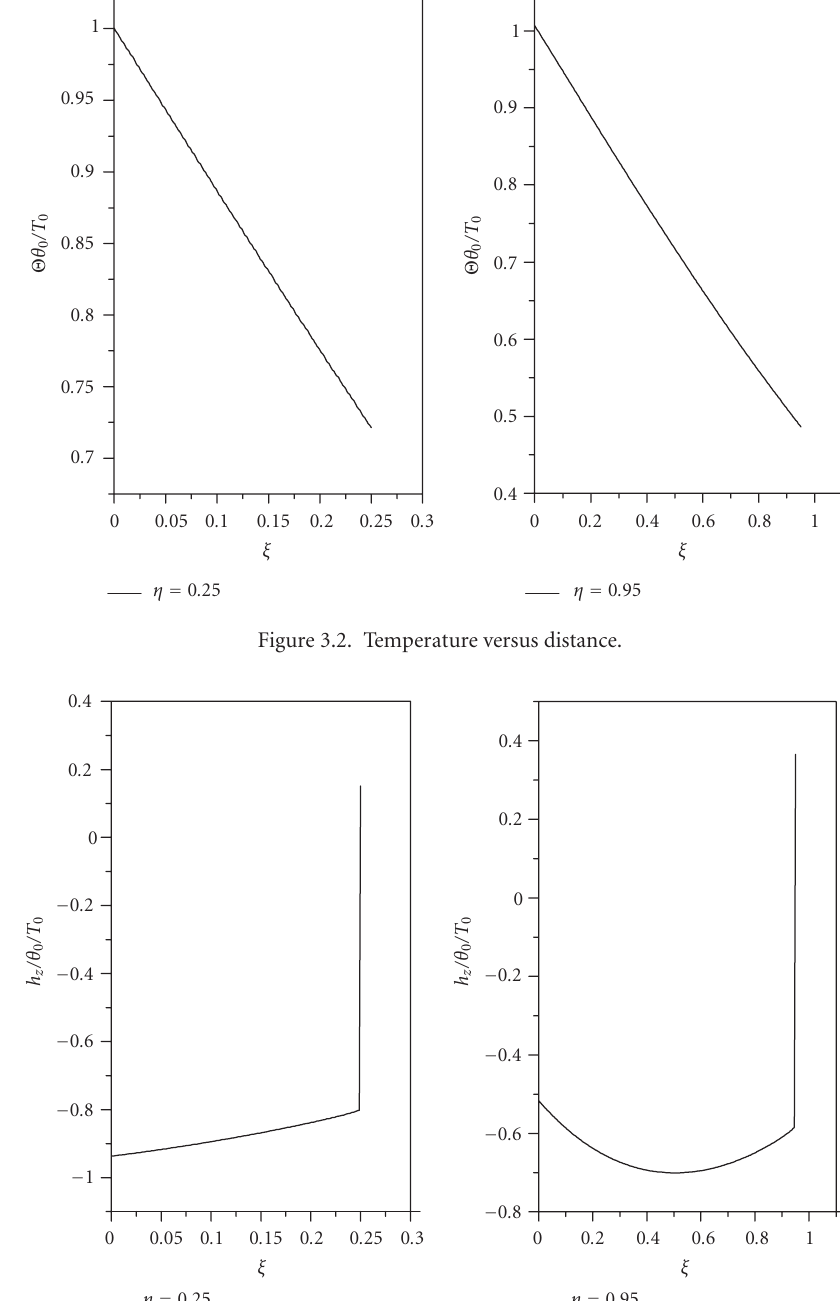
Figure 3.3. Perturbed field versus